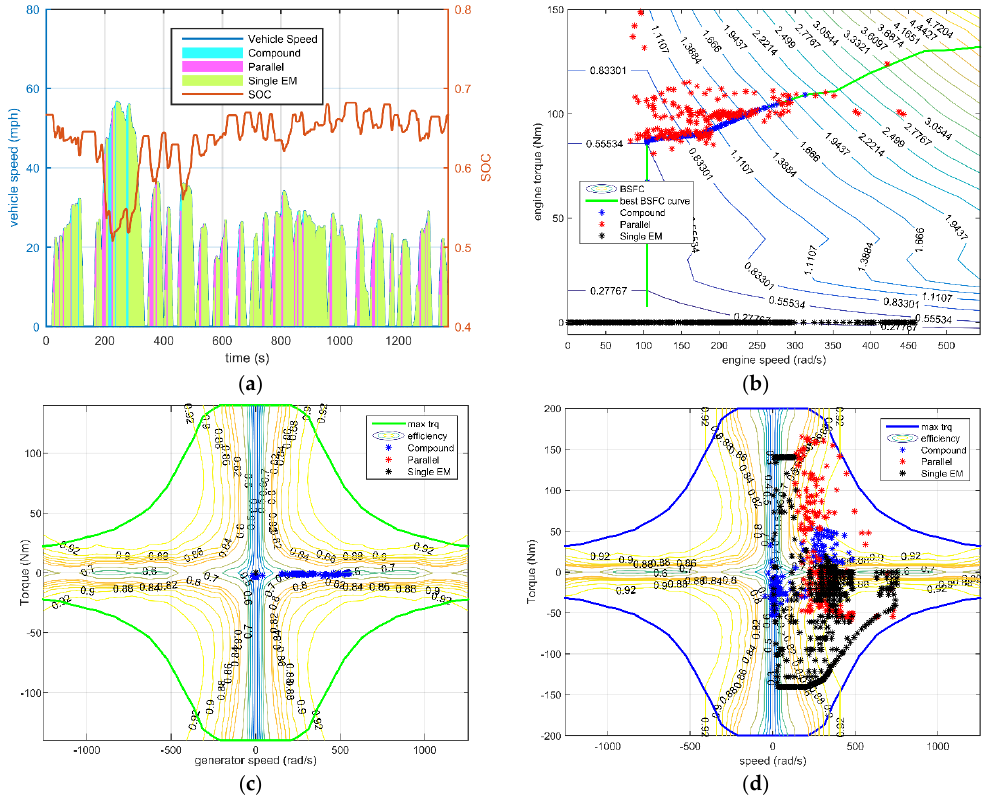
Figure 13. ( a ) Battery SoC trajectory and mode selection over the UDDS drive cycle; ( b ) engine optimal operation points over the UDDS drive cycle; ( c ) EMA operating points over the UDDS drive cycle; and ( d ) EMB operating points over the UDDS drive